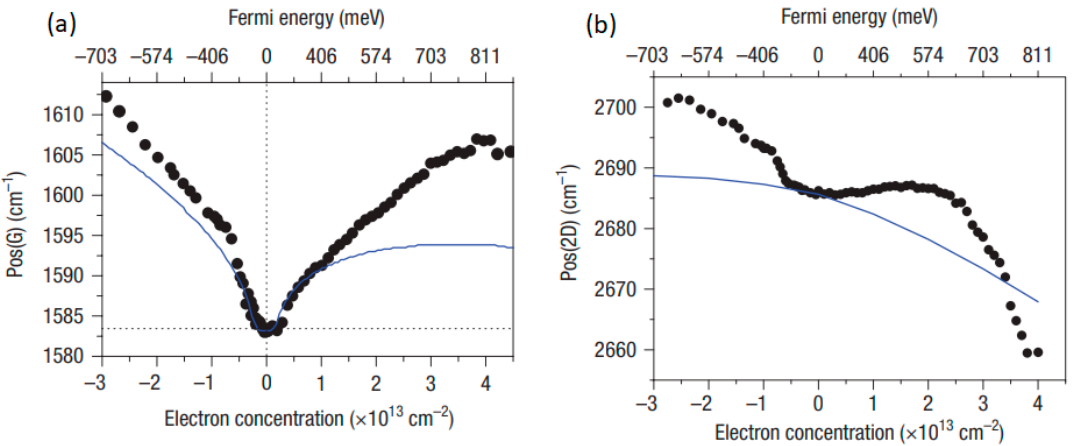
Figure 7. Position of the ( a ) G peak and ( b ) 2D peak as a function of electron and hole doping in graphene on SiO 2 . The solid blue line in ( a ) is the predicted non-adiabatic trend from Reference [71]. The solid line in ( b ) is from density functional theory calculation. Reprinted with permission from Reference [65]. Copyright (2008) Springer Nature.